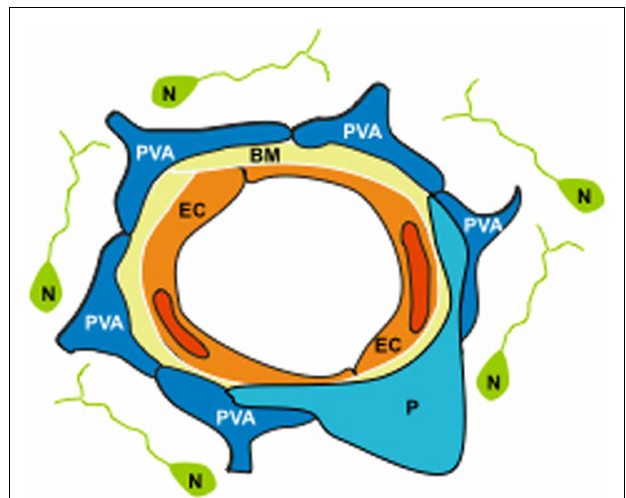
FIGURE 1 |The neurovascular unit (NVU) is assembled by endothelial cells (EC) ensheated by a basement membrane (BM), embraced by perivascular astrocytes (PVA) and pericytes (P), and surrounded by neurons (N)